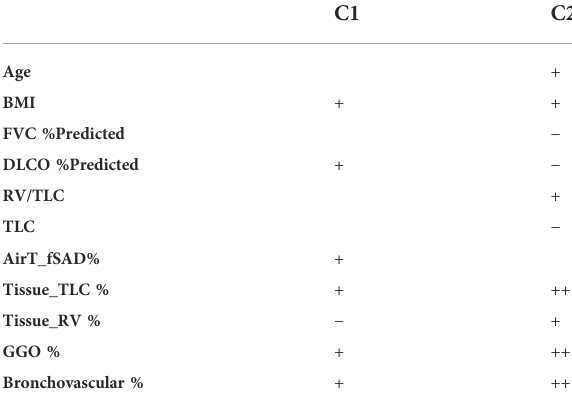
TABLE 2 Summary of the cluster characteristics. A “ + ” and a ‘ − ’ denote that the Post-COVID-19 clusters were signi fi cantly greater and less than the control group in terms of the given